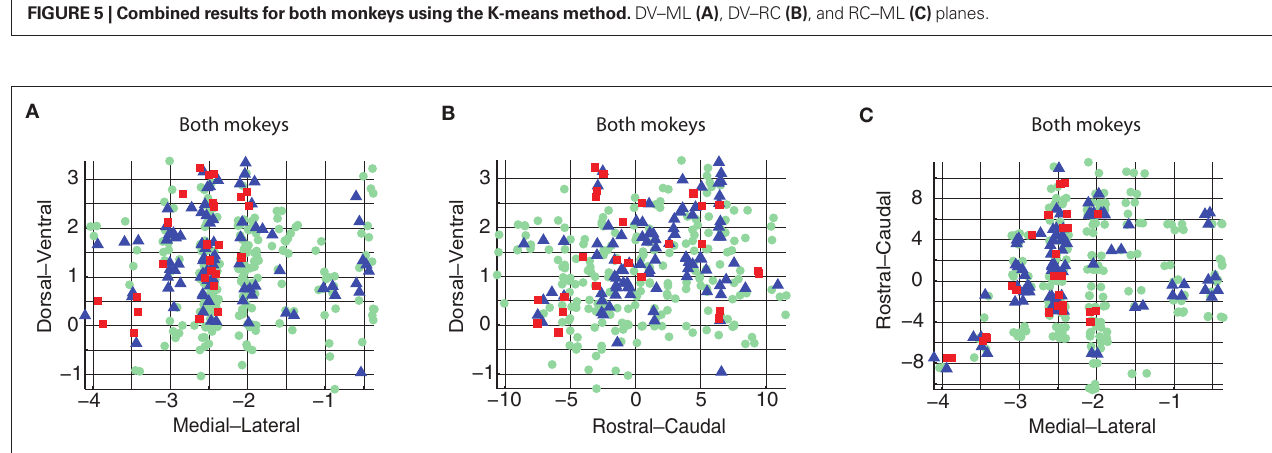
FigUre 6 | Combined results from both monkeys using the AVPSD method. DV–ML (A) , DV–RC (B), and RC–ML (C) planes.